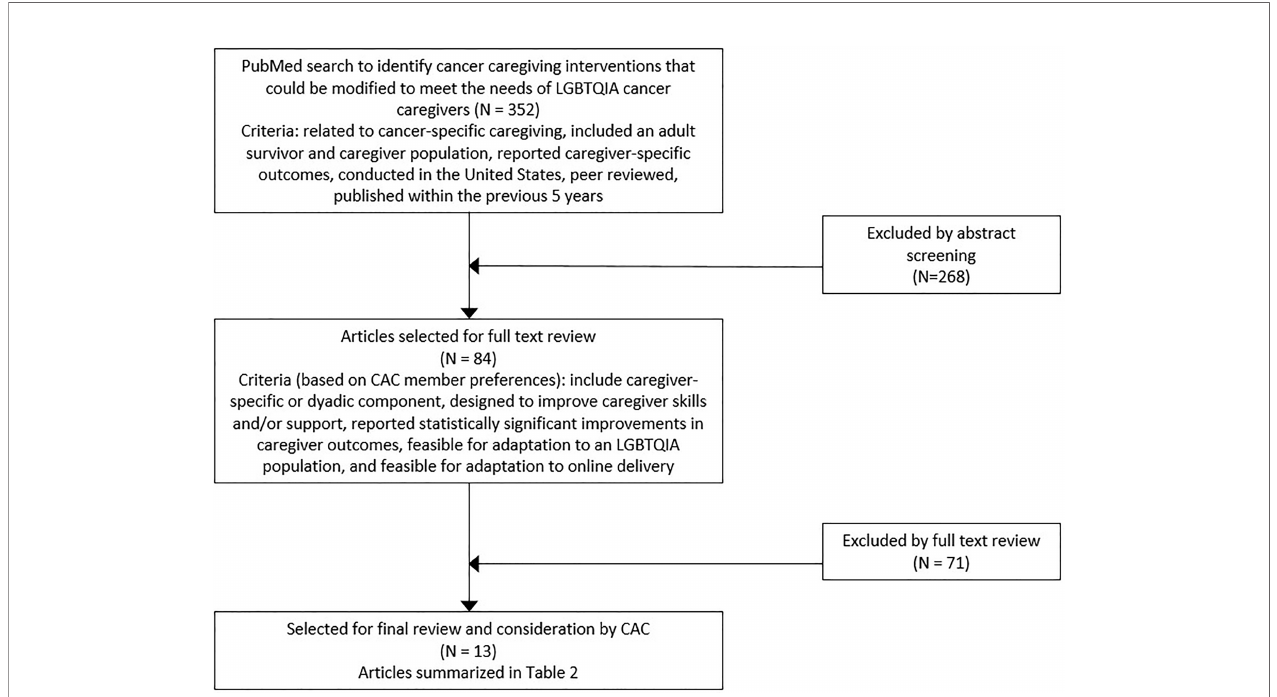
FIGURE 1 | Flow diagram of studies included in literature review of interventions that improved informal cancer caregiver wellbeing for potential adaptation for LGBTQIA